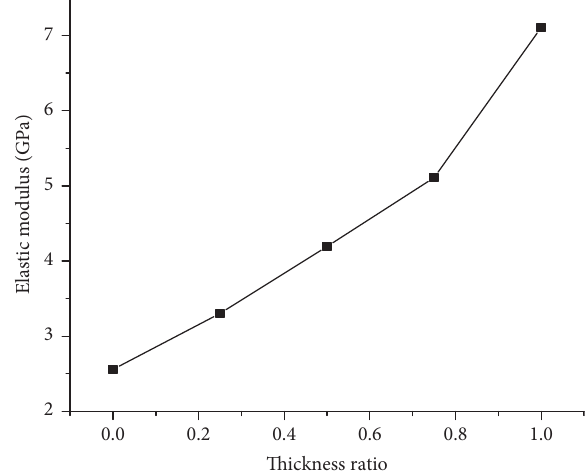
Figure 4: Axial stress-strain curves of uniaxial compression.